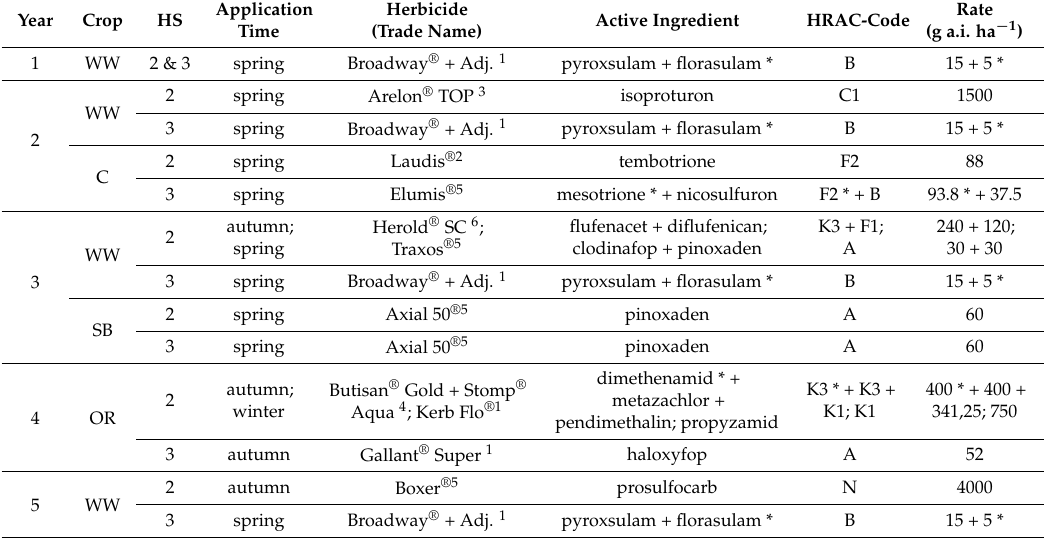
Table 2. Herbicides applied in different crops and years to control A. myosuroides